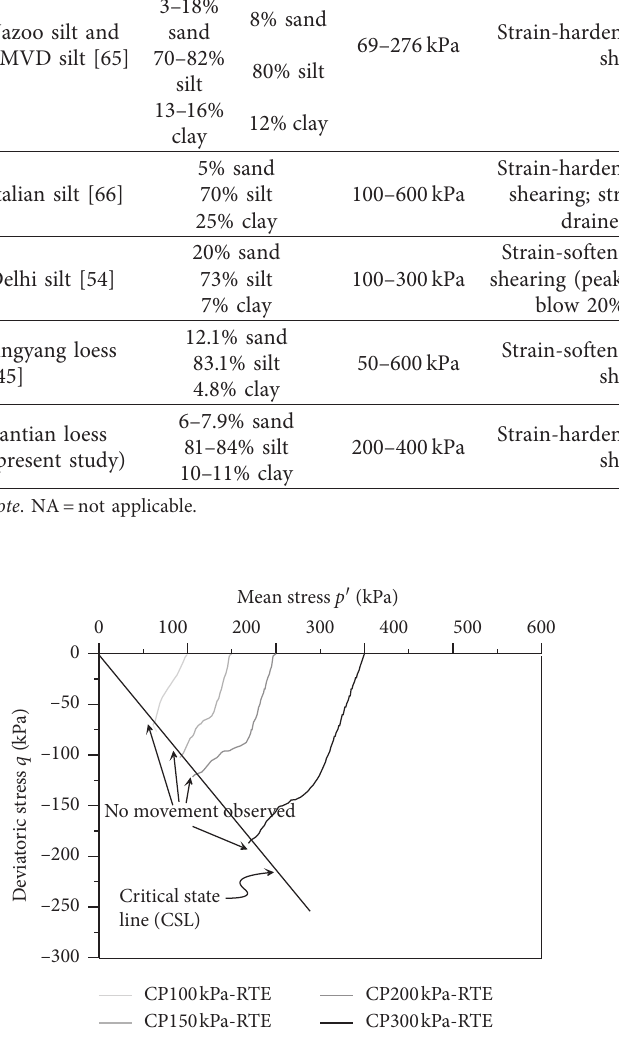
Figure 10: Effective stress paths of Delhi silt and failure line in p ′ − q space.